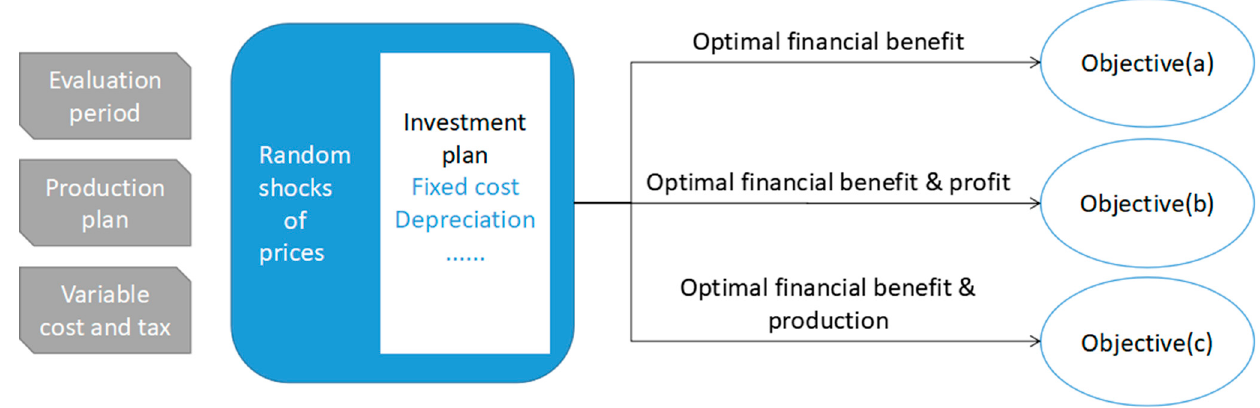
Figure 1. Information set and decision process.